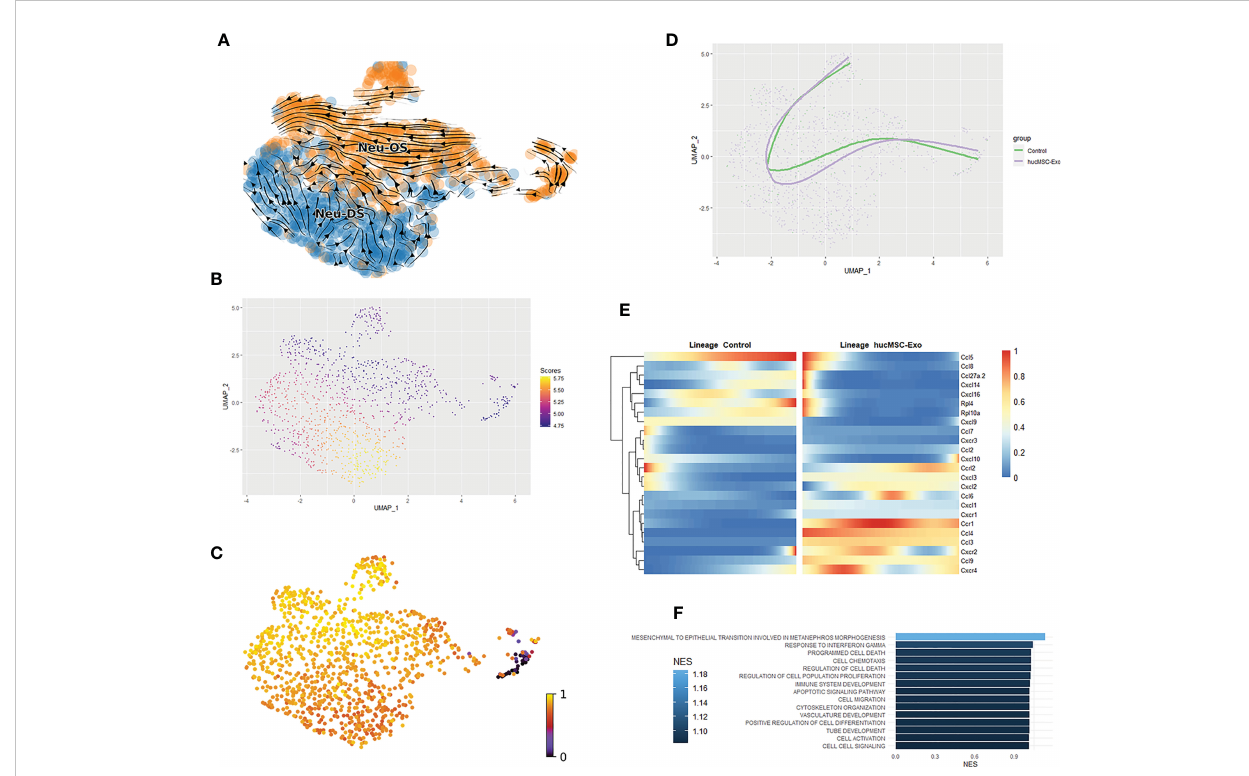
FIGURE 3 Pseudotime and RNA velocity pro fi les of neutrophils. (A) Scatterplot of neutrophils RNA velocity graph. (B) Scatterplot for imbalance score for neutrophils. Bright yellow regions indicate that nearby cells share the same condition. Deep blue regions mean that nearby cells are from a mix of the hucMSC-Exosomes group and the control group. (C) Latent time graph based on UMAP reduction of neutrophils; cells are colored based on latent time. (D) Scatter and trajectory plot based on UMAP reduction of neutrophils. (E) Heatmap of gene ’ s differential expression between conditions along the trajectory. (F) Barplot of the hucMSC-Exosomes groups vs the control group relevant GSEA elevated from differentially expressed genes between conditions along the